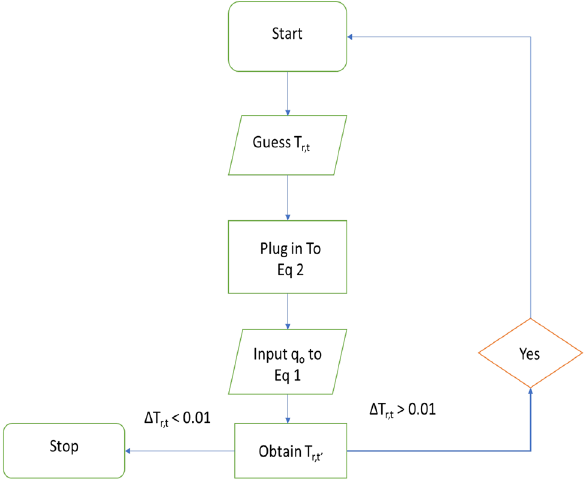
Fig. 1 Trial and error calculation